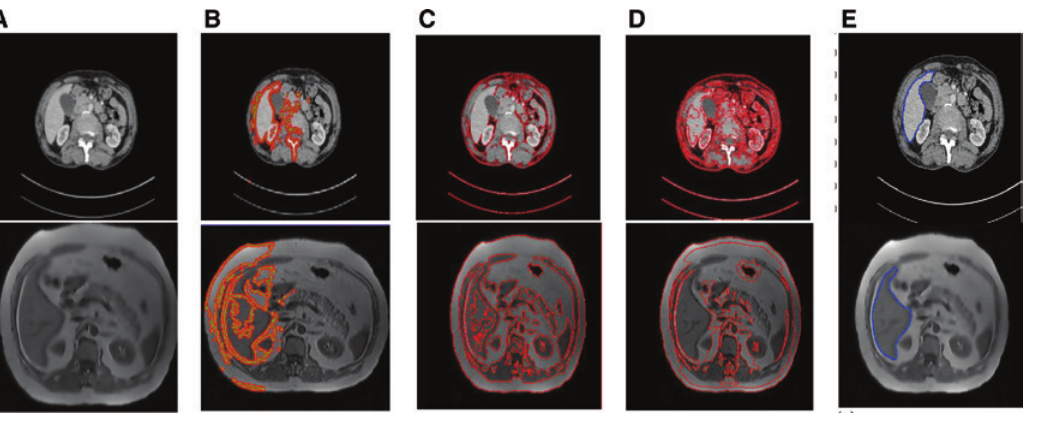
Figure 6: Comparison Result of Proposed Method with Existing Method. Column (A) Original CT Scan and MRI Scan. (B) Result of C – V Model on CT Scan and MRI Scan. (C) Result of LSE Model on CT